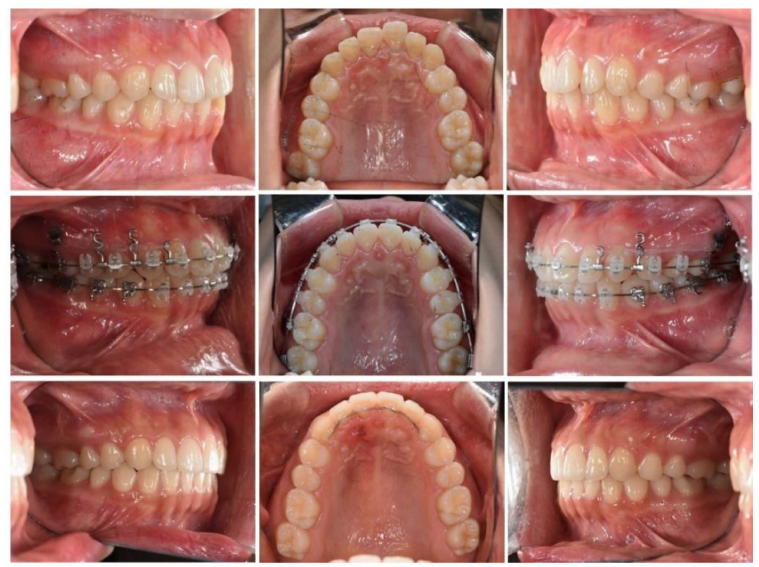
Figure 2. The TADs were placed in the posterior interradicular buccal area for maxillary molar distalization (group 1). From the upper: pretreatment, during treatment, and post-treatment. In group 2, two miniscrew-type TADs (1.6 mm diameter × 6 mm length, 0.0215 × 0.025 inch slot size) (Machined-surface miniscrews, Jeil Medical, Seoul, Korea) were used as a rigid bone anchor. The screw was bilaterally inserted into the median palatal suture, and a lingual arch appliance (round 0.032 inch stainless steel wire) was placed on the palate, connecting the right and left first molars, and attached to a palatal bar (rectangular 0.021 × 0.025 inch stainless steel archwire) engaged through the head slot of the two palatal TADs (Figures 1 and 3). Closed-coil nickel–titanium springs were applied with a distal driving force of 150 g, and an elastomeric power chain (Ormco, Glendora, CA, USA) was replaced at 4-week intervals for molar distalization. Fixed buccal appliances with thicker than rectangular 0.016 × 0.022 inch stainless steel archwires were simultaneously used during molar distalization.